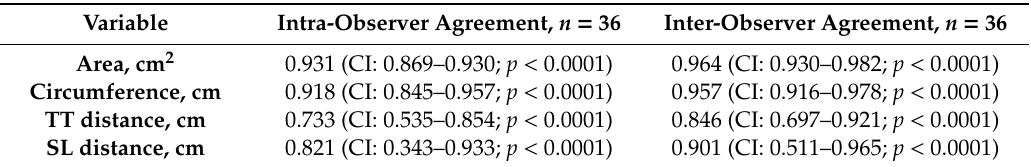
Table 3. Intra- and inter-observer variability of assessment of mitral annular dimensions with 4D Auto MVQ.